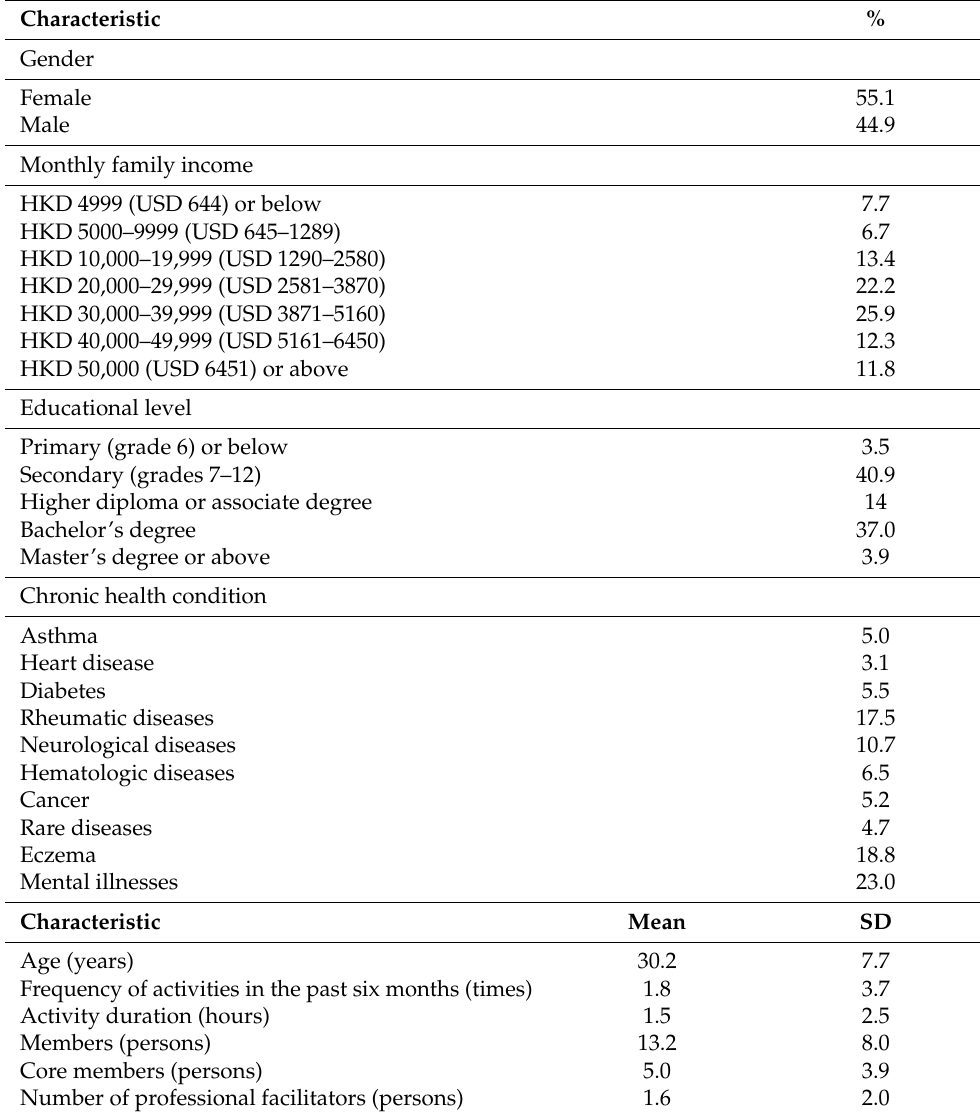
Table 1. Demographic information of participants ( n =